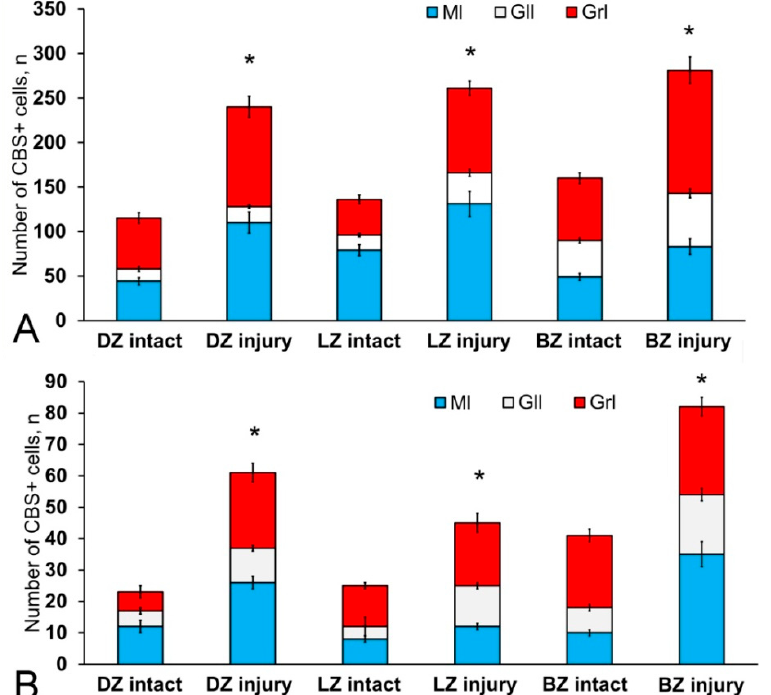
Figure 13. Distribution of CBS+ cells in the intact cerebellum of juvenile Oncorhynchus masou and after injury. ( A ) Proportion of round, type 1 CBS+ cells in intact animals and after injury. ( B ) Proportion of oval CBS+ type 2 cells in intact animals and after injury ( n = 5 in each group; * p ≤ 0.05 is a significant difference vs. control groups). Student–Newman–Keuls test. The X-axis indicates the cerebellar area. DZ, dorsal zone; LZ, lateral zone; BZ, basal zone; Ml, molecular layer; Grl, granular layer; Gll, ganglionic layer.